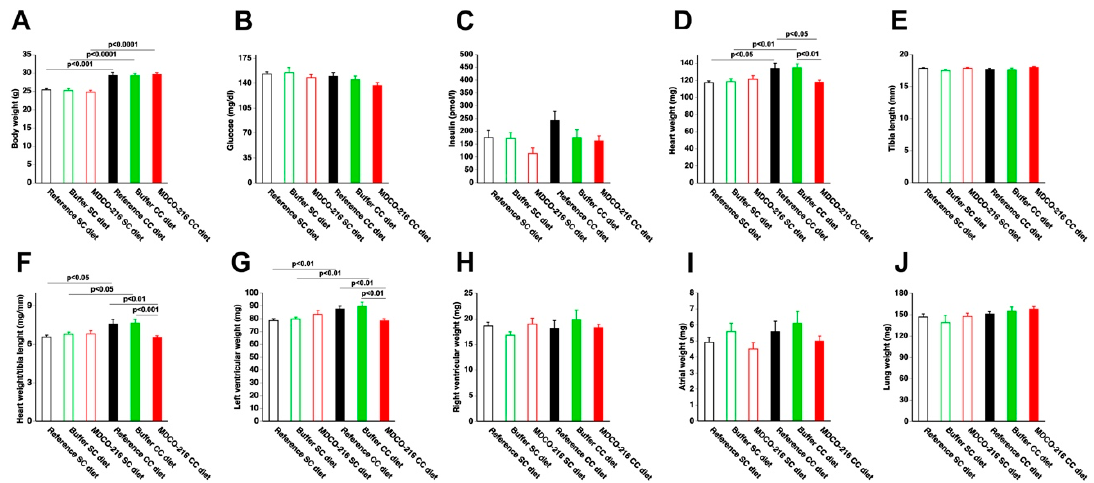
Figure 4. Body weight ( A ), glucose level ( B ), insulin ( C ), heart weight ( D ), tibia length ( E ), heart weight/tibia length ( F ), left ventricular weight ( G ), right ventricular weight ( H ), atrial weight ( I ), and lung weight ( J ) in C57BL/6 SC diet mice and in C57BL/6 CC diet mice. CC diet was initiated at 12 weeks of age. Quantifications were performed at 38 weeks (reference mice) or at 40 weeks (buffer mice and MDCO-216 mice) on SC diet or CC diet. SC diet mice and CC diet mice are indicated by open bars and closed bars, respectively. All data represent means ± SEM ( n = 15).